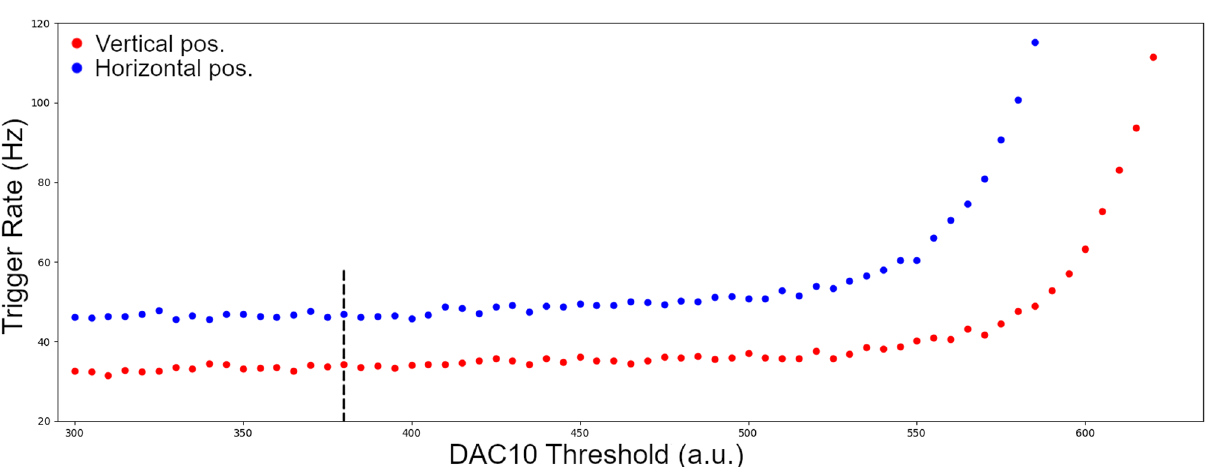
Figure 4. The trigger rate as a function of the discriminator threshold. High value of the DAC10 register corresponds to lower values of the discriminator. The dashed line indicates the threshold value corresponding to a cut-off value of 5–6